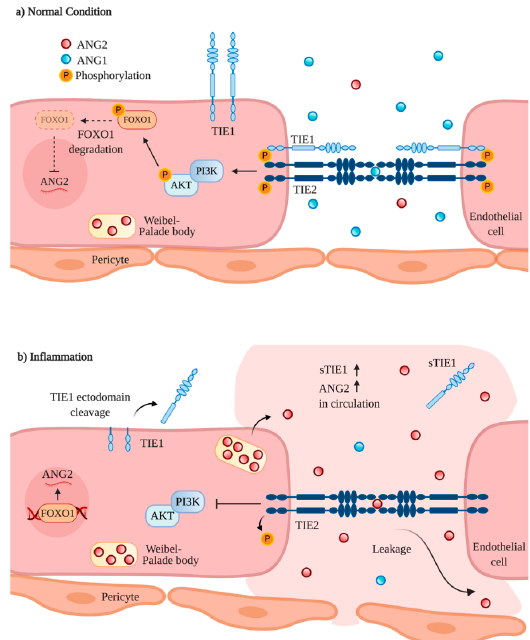
Figure 2. Angiopoietin-TIE signaling under normal conditions and inflammation. ( a ) Under normal conditions, when ANG2 expression is low, ANG2 is stored in Weibel–Palade bodies. ANG1, which dominates ANG2 levels, binds to and activates TIE2. Along with co-receptor TIE1, TIE2 is phosphorylated (p-TIE2), which in turn activates phosphoinositide 3-kinase (PI3K / AKT) signaling. Phosphorylated AKT inactivates the forkhead transcription factor (FOXO1) via nuclear exclusion, inhibiting further ANG2 expression. As a result, vessel quiescence and vascular stability are maintained. ( b ) In inflammation, ANG2 is upregulated and competes with ANG1 for TIE2 receptor binding. The ectodomain of co-receptor TIE1 is cleaved leading to p-TIE2 suppression and PI3K / AKT inactivation. Consequently, activated FOXO1 increases ANG2 expression, which sustains positive feedback of TIE2 signaling suppression and ultimately contributes to vascular destabilization and